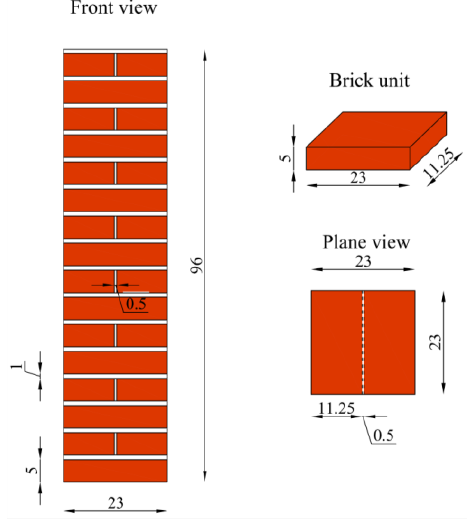
Figure 1. Geometry of test specimens (units in cm).